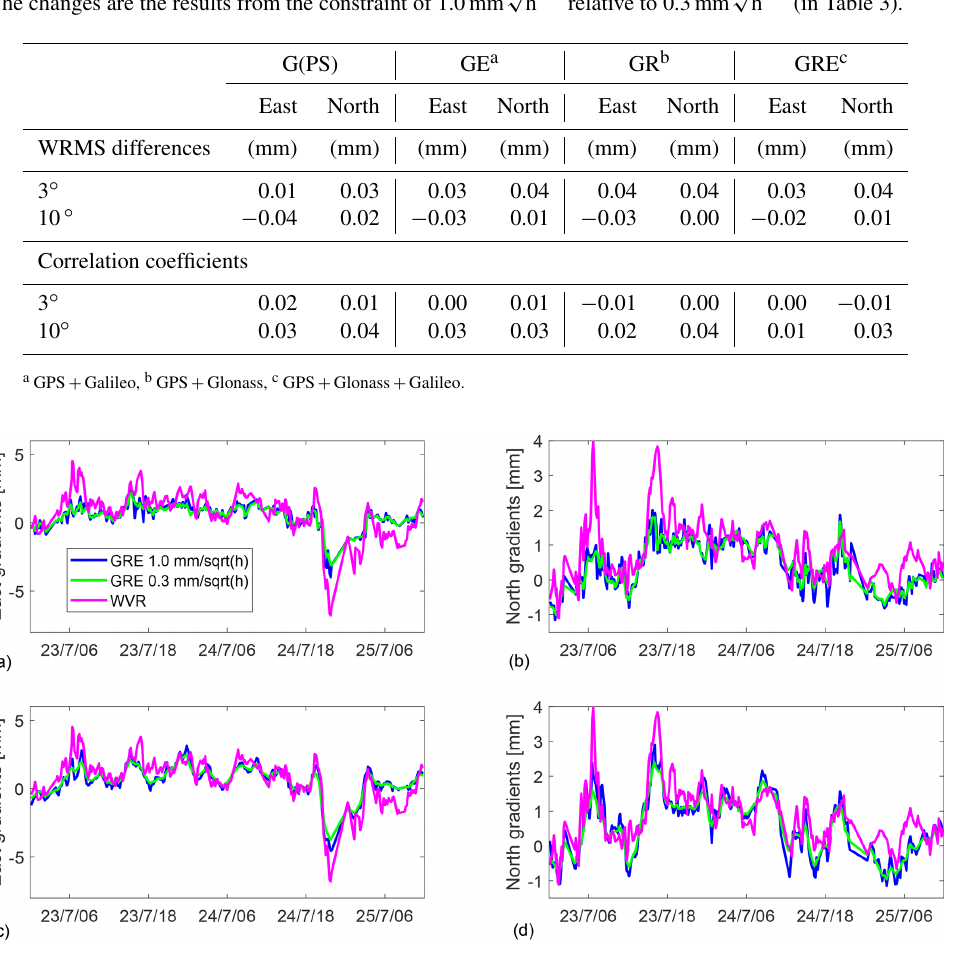
Figure 12. Gradient time series from the WVR and from the GNSS (GRE) applying two different constraint values (0.3 and 1.0mm and using elevation cutoff angles of 3 ◦ (a,b) and 10 ◦ (c,d)